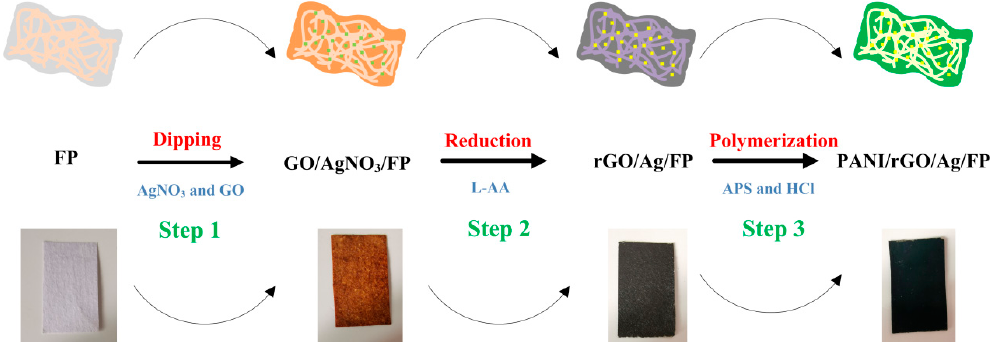
Figure 1. Fabrication of the flexible polyaniline (PANI)/rGO/Ag/filter paper (FP) hybrid electrode.